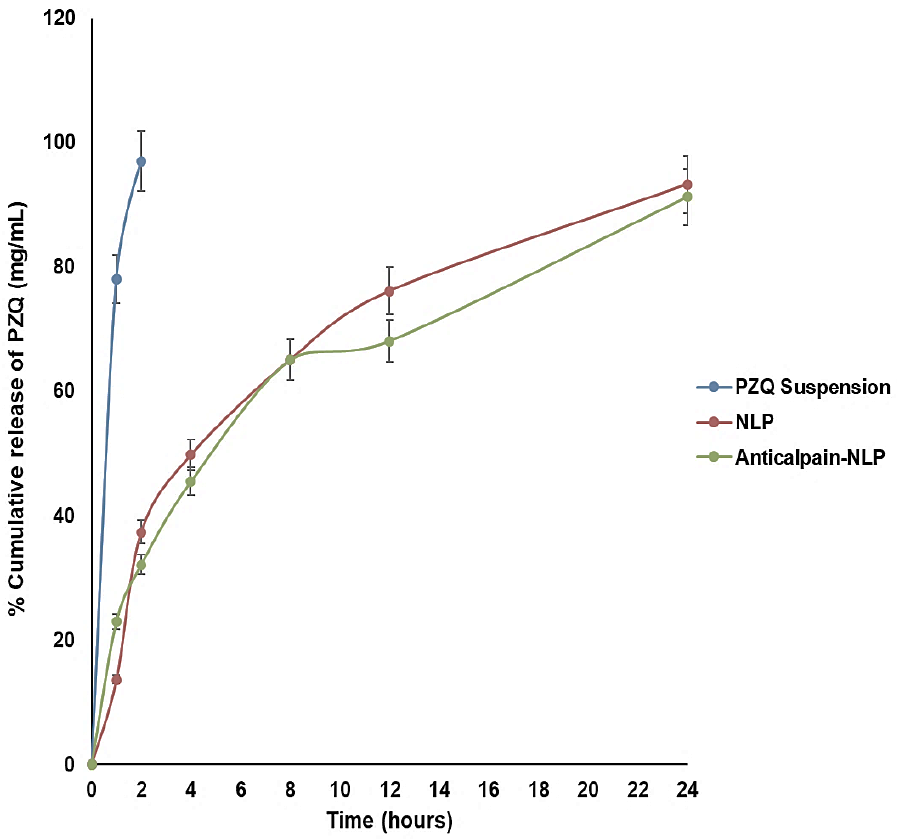
Figure 5. In vitro release profile of free PZQ and NLP. Release medium = PBS; Temperature = 37 ± 1 ◦ C; pH = 7.4 ( n = 3, mean ± SD).